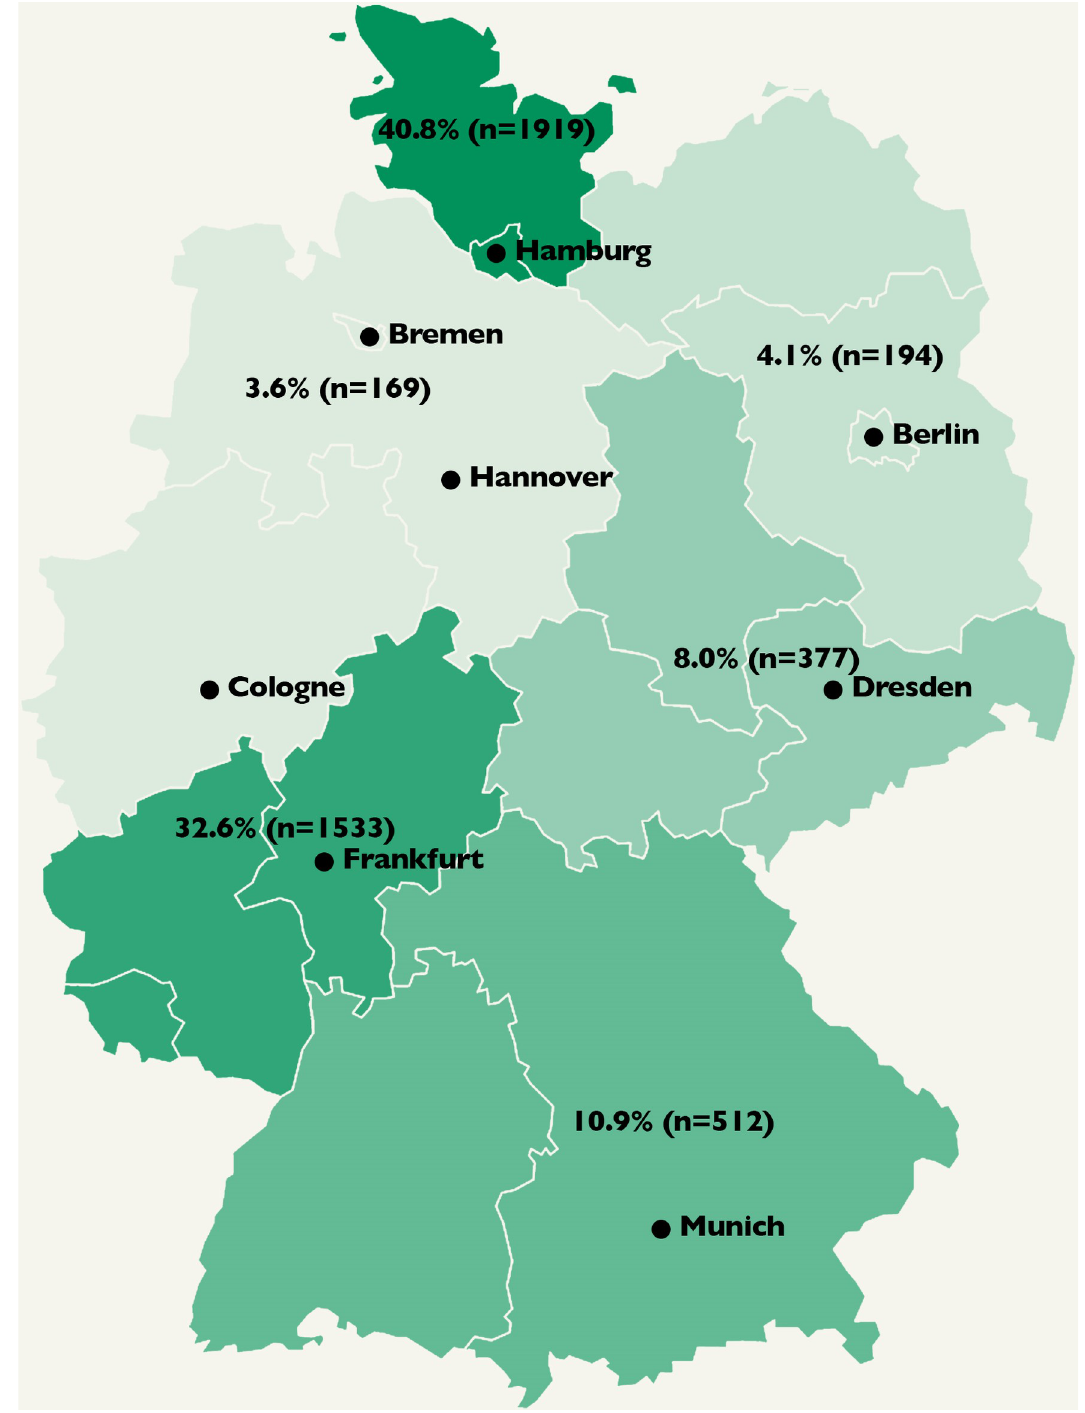
Fig 1. Patient distribution of the 4704 included patients in Germany. The map of Germany is divided into northern, northeastern, northwestern, south, southeastern and southwestern Germany.